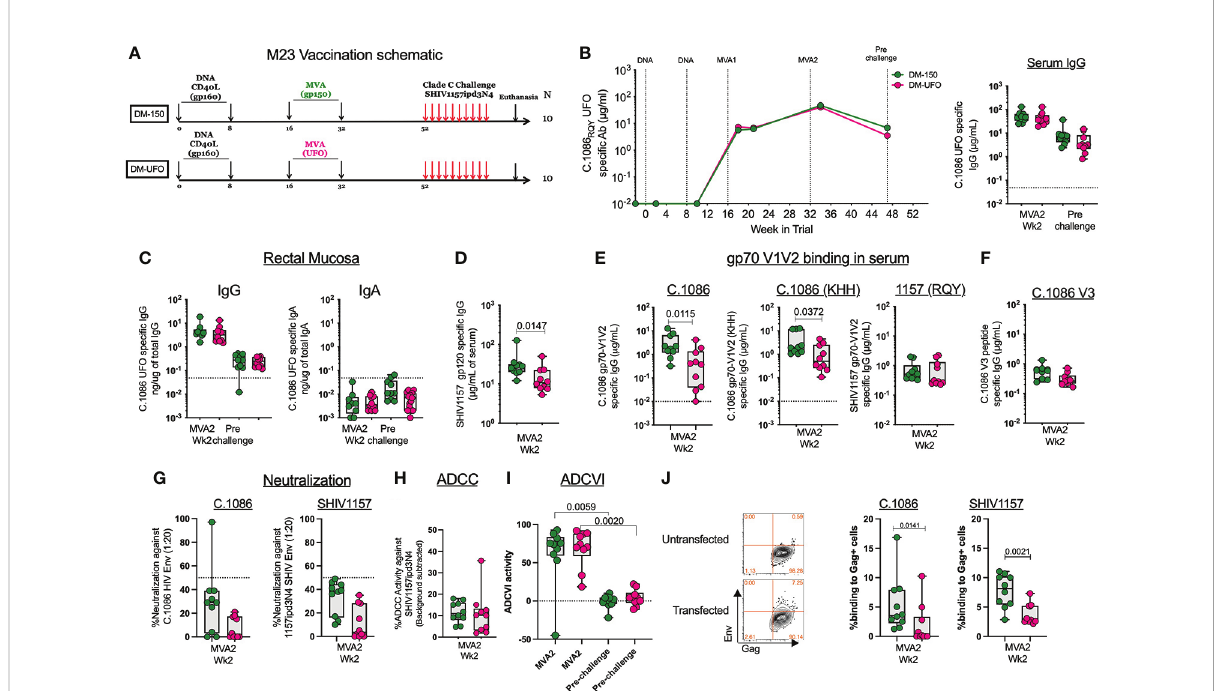
FIGURE 3 Humoral immunity following vaccination. (A) Schematic of the vaccine strategy. (B) Longitudinal serum antibody response to C.1086 gp140 UFO protein. (C) C.1086 gp140 UFO IgG and IgA antibody responses in the rectal secretions at the peak and prechallenge time points. (D) SHIV1157ipd3N4 gp120 serum binding antibody responses post MVA2. (E) Serum binding antibody responses to C.1086, C.1086_KHH, and SHIV1175 gp70 V1V2 constructs post MVA2. (F) C.1086 V3 binding antibody responses post MVA2. (G) Neutralization activity against C.1086 (RQY) and SHIV1157ipd3N4 pseudoviruses post MVA2. (H) ADCC activity against the challenge virus, SHIV1157ipd3N4, post MVA2. (I) ADCVI against SHIV1157ipd3N4 at the MVA2 (peak) and prechallenge time points (J) Binding of serum antibody post MVA2 to 293 T cells transfected with DNA/SHIV C.1086 or DNA/SHIV